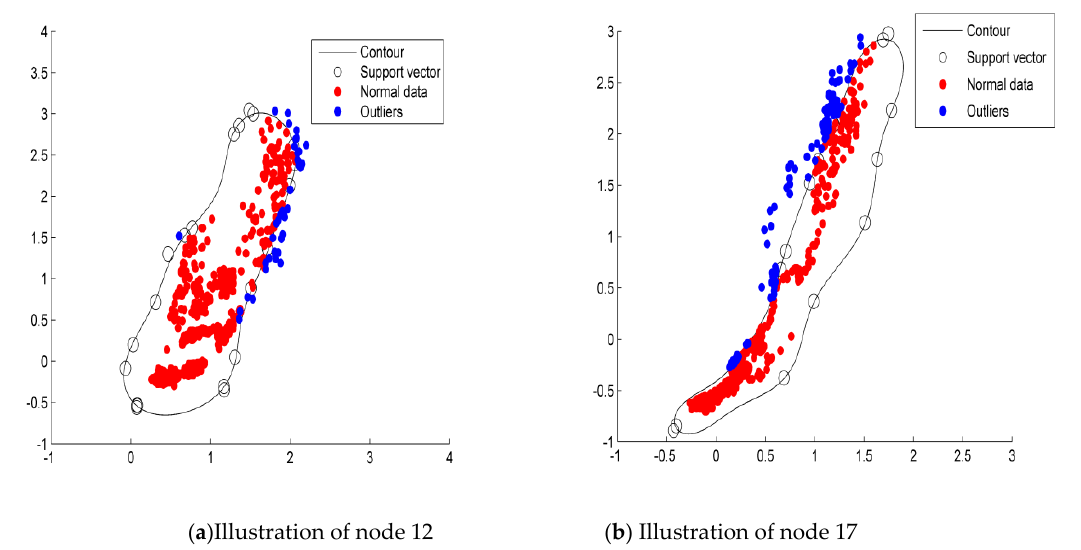
Figure 2. Distribution of the SensorScope dataset.